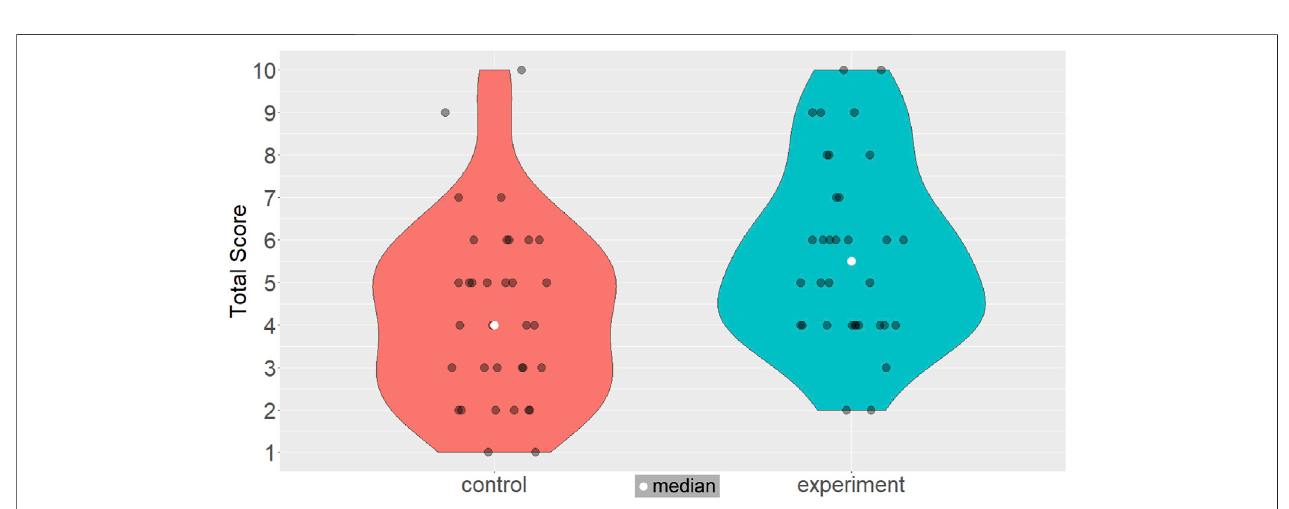
FIGURE 11 | These violin plots show a signi fi cant difference in the mid-questionnaire score between the two cohorts.